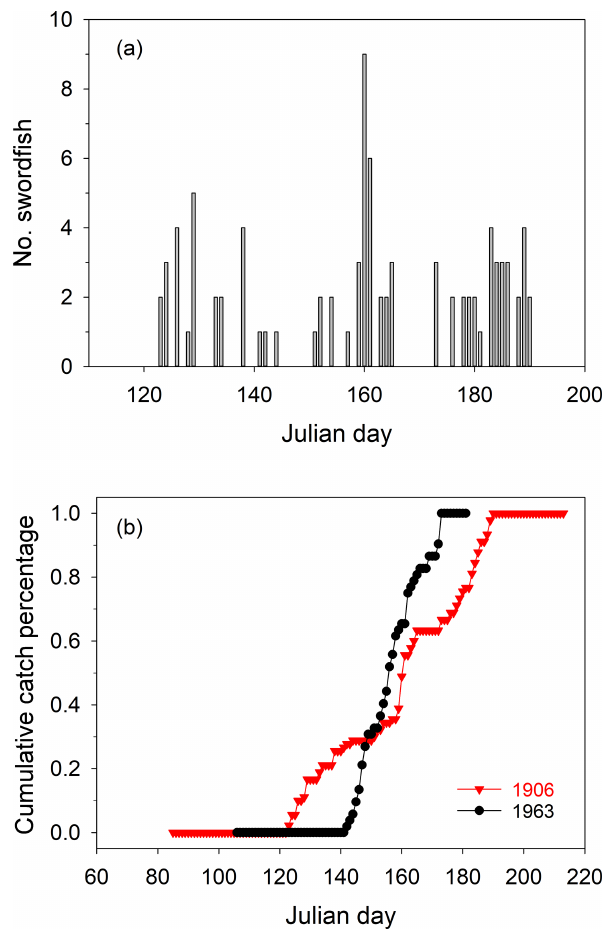
Figure 3. Examples of swordfish bycatch data extracted from bluefin tuna trap records. These data are from the trap located in Milazzo (see location in Fig. 1). (a) Bycatches on each day dur- ing the fishing season of 1906; (b) the cumulative catch percent- age throughout the fishing season of 1906 and, for comparison, of 1963. Similar data are available in the recovered data for a to- tal of 43 years (see also Table 2 and data files stored at Pangaea, https://pangaea.de/, last access: 5 December 2021).